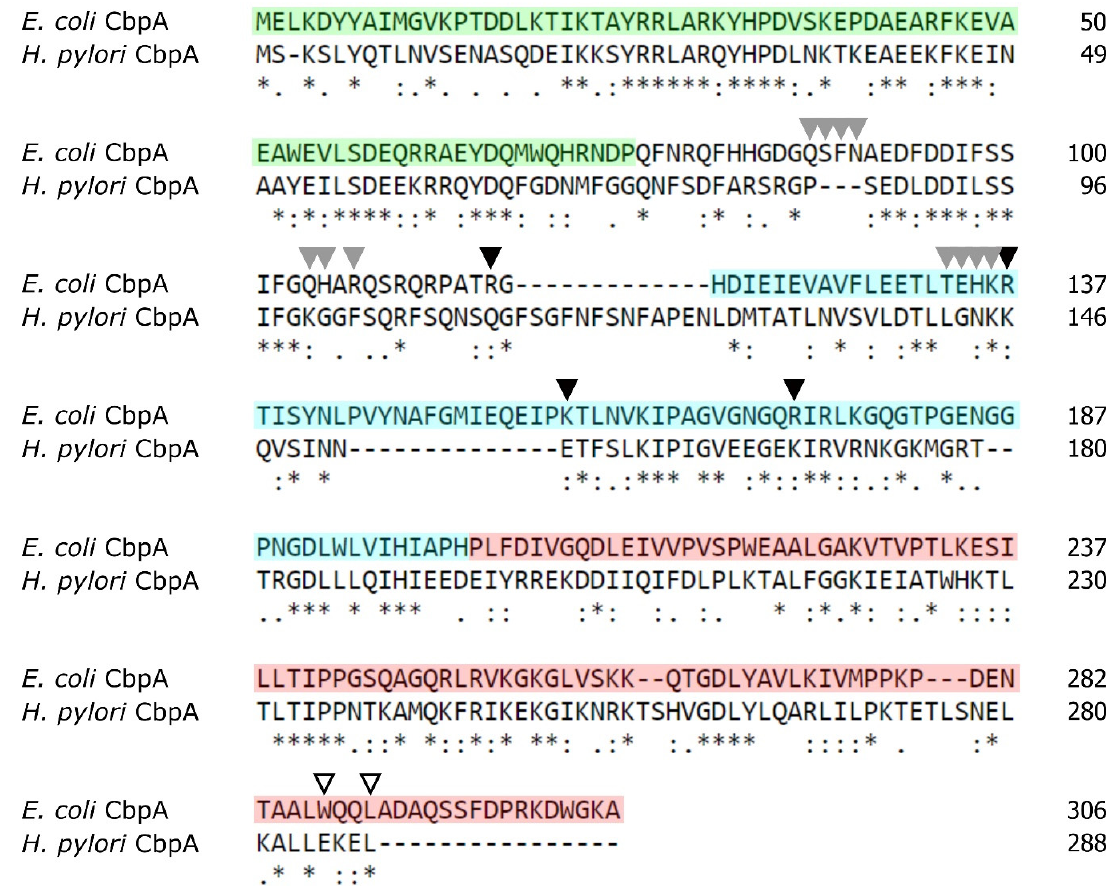
Figure 1. Conservation between E. coli and H. pylori CbpA proteins. Primary sequence comparison between E. coli and H. pylori CbpA was carried out using the T-Coffee Multiple Sequence Analysis online tool [21]. Symbols: asterisk (*), amino acid identity; colon (:), strong amino acid conservation; period (.), weak amino acid conservation [21]. The experimentally characterized functional domains of E. coli CbpA are indicated as follows: J-domain (aa 1 to aa 75): green; linker (aa 76 to 117): not highlighted; CTDI (aa 118 to aa 201): cyan; CTDII (aa 202 to aa 306): red. Grey and black arrowheads indicate residues involved in DNA binding (according [8] and [11], respectively), while empty arrowheads denote crucial residues for CbpA dimerization (according to [10]).